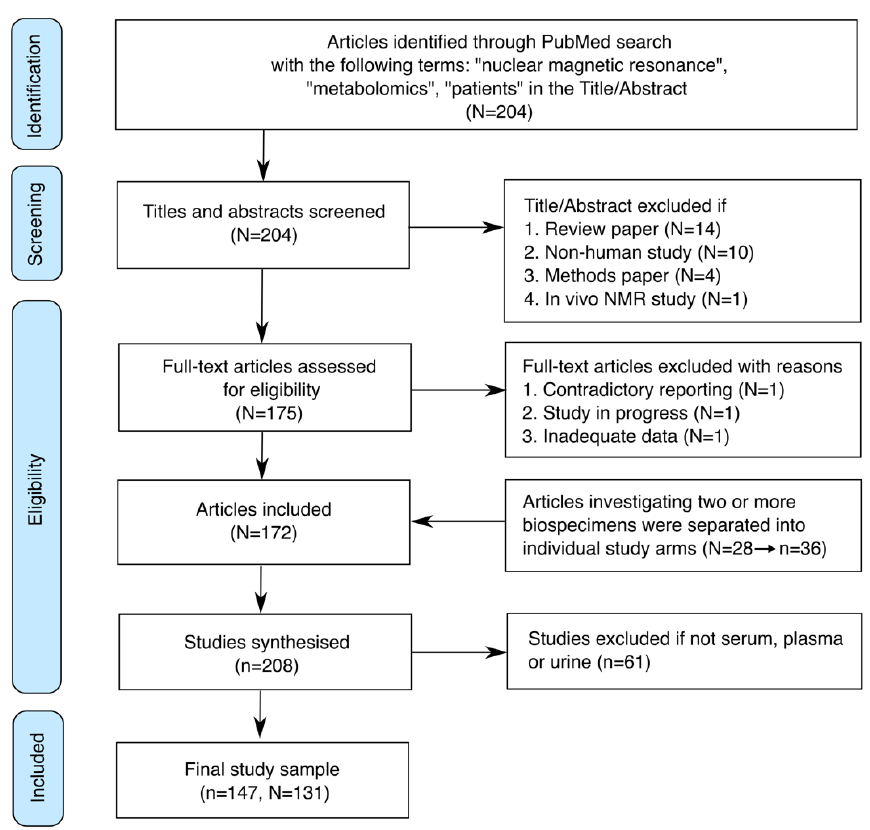
Figure 1. Preferred reporting items for systematic reviews and meta-analyses (PRISMA) flow diagram. After screening 204 articles, we synthesised 147 studies analysing NMR metabolomics workflows. N = number of articles, n = number of individual study arms.